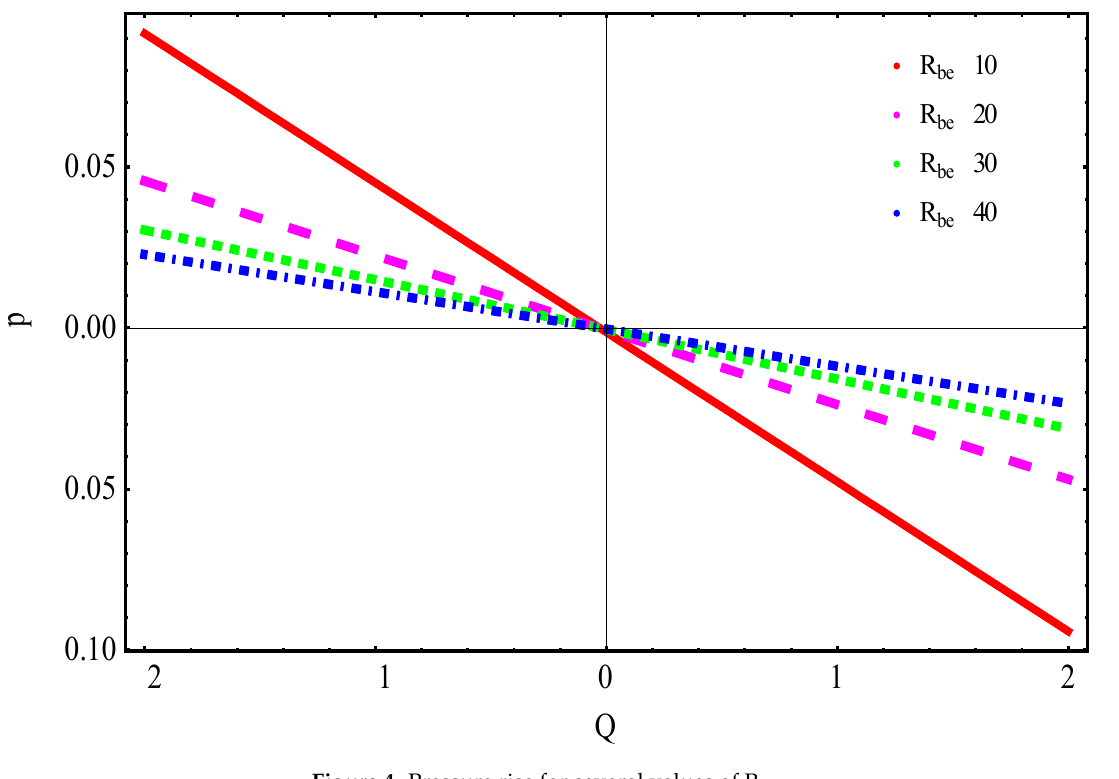
(cid:2912)(cid:2915) .